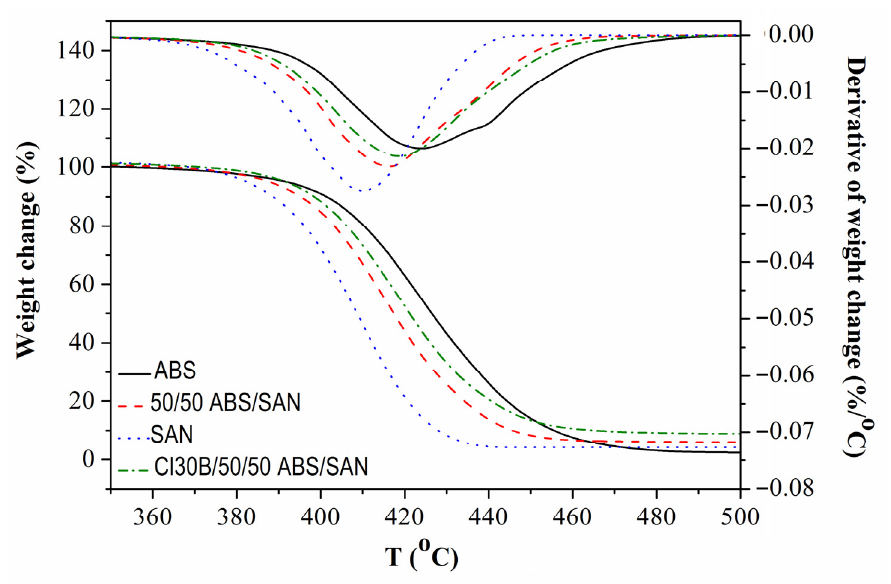
Figure 4. TGA and DTG curves for ABS, SAN, and 50/50 w / w ABS/SAN blend and its nanocomposite.